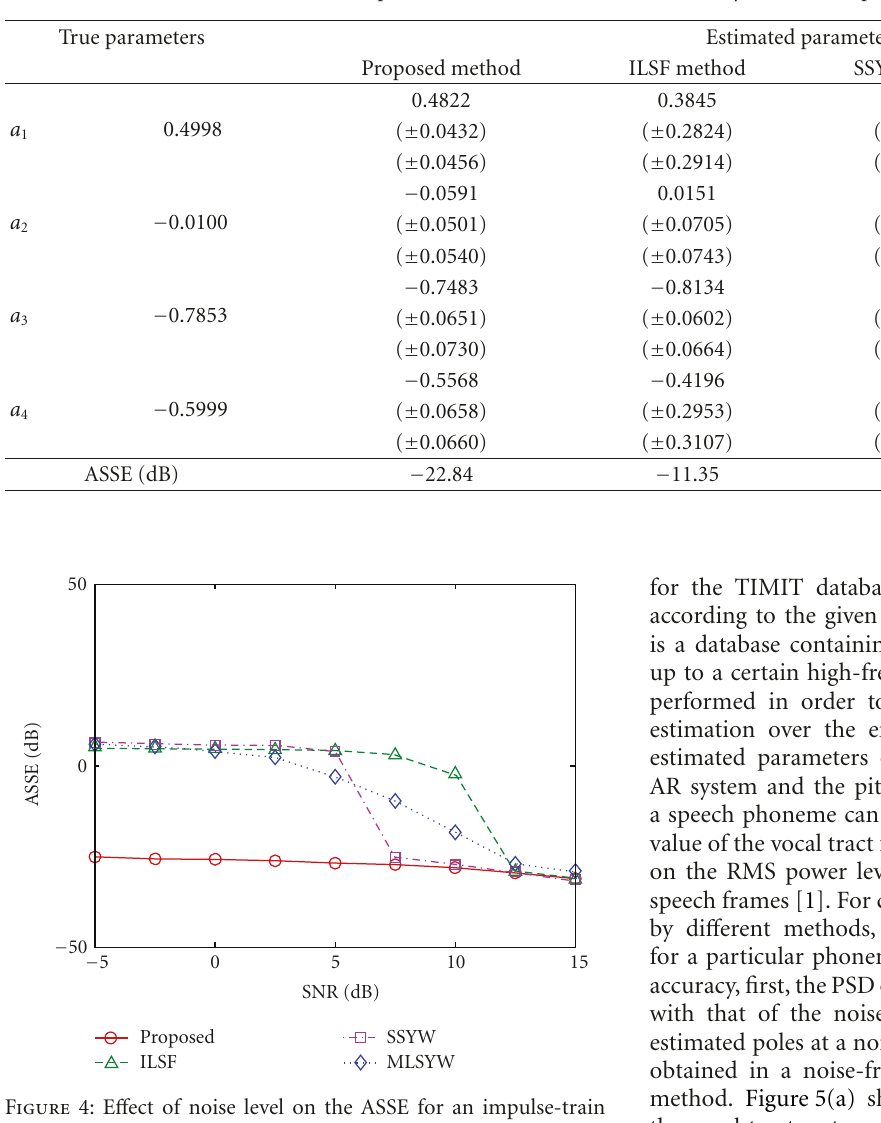
Figure 4: E ff ect of noise level on the ASSE for an impulse-train excited